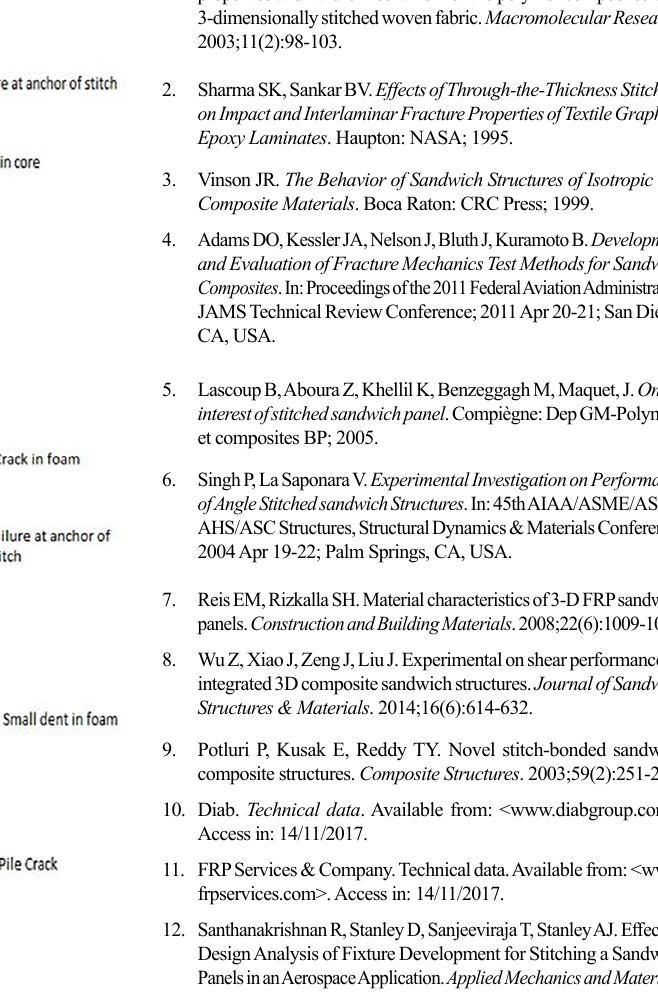
Figure 12. 90º Stitched specimen.